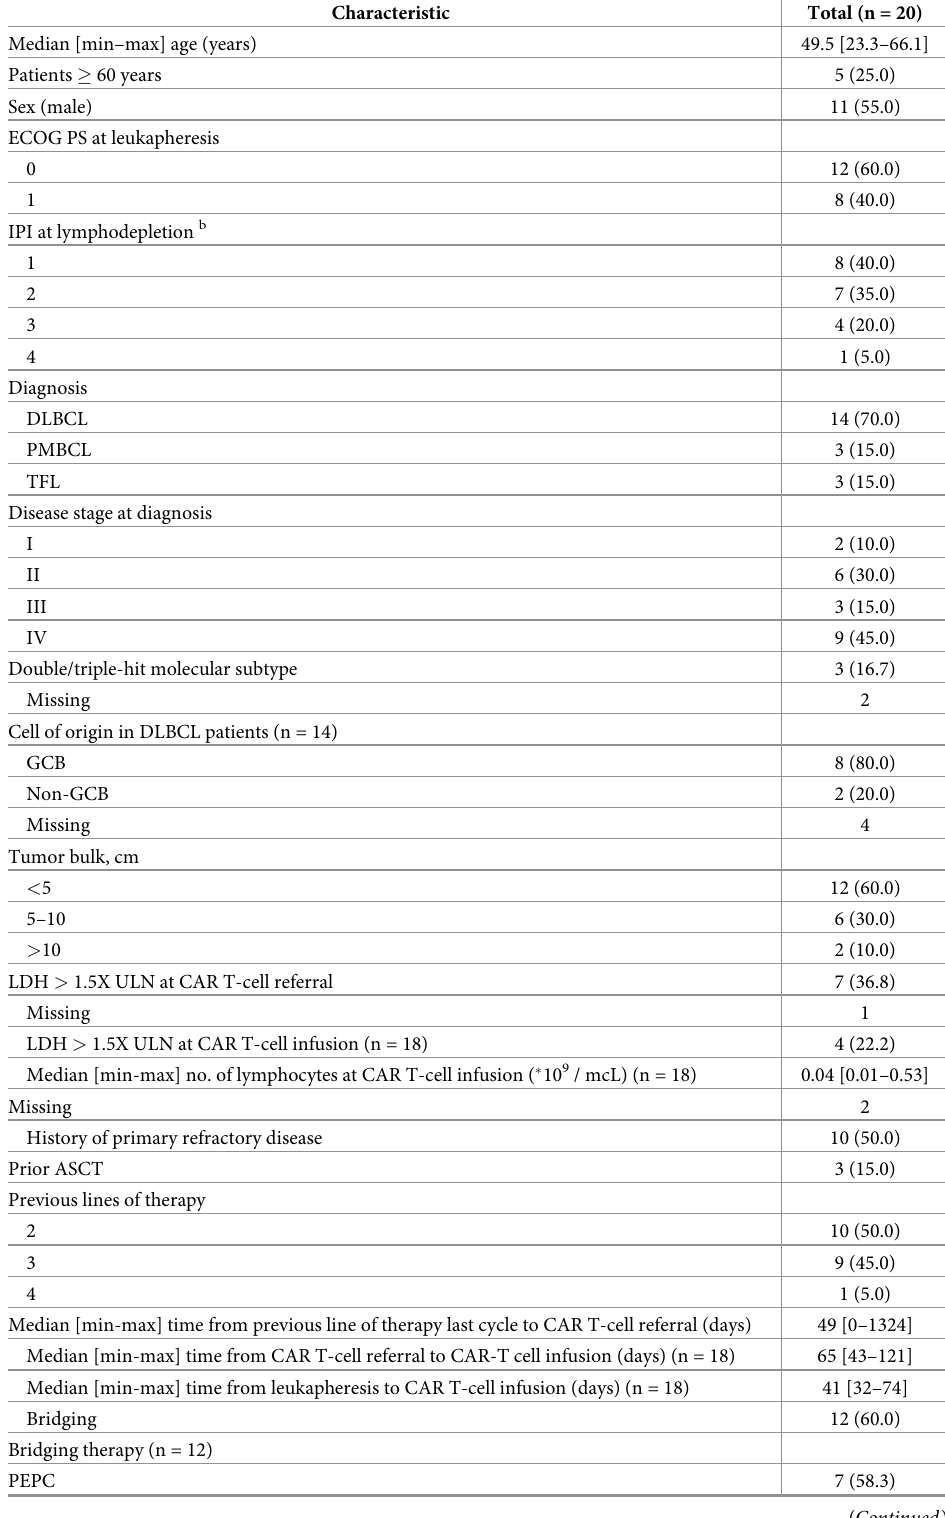
Table 1. Baseline patient characteristics a